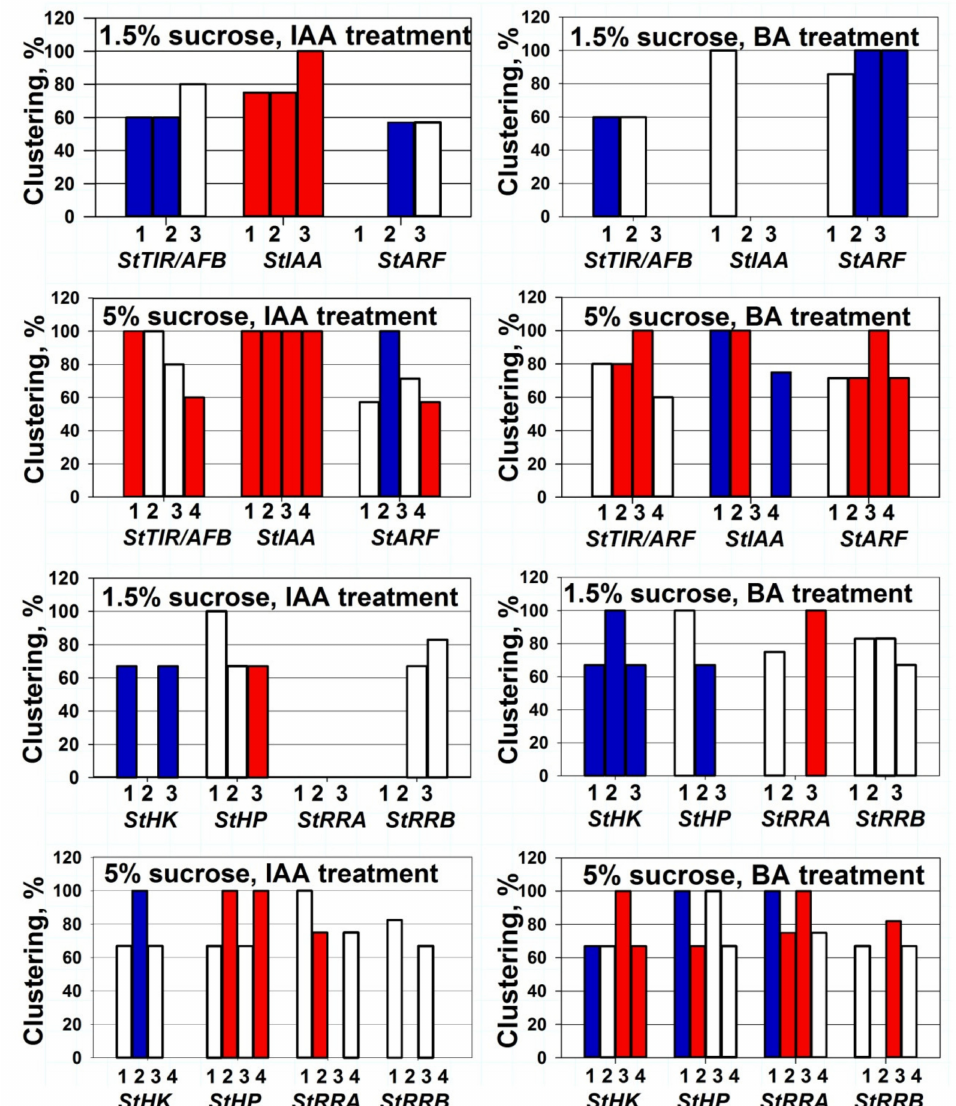
Figure 5. Cluster-like response (co-expression) of potato auxin/CK signaling genes to hormone treatments. 1, 2, 3, and 4 designate potato organs: leaves, stems, roots and tubers, respectively. Color indicates the change mode of cluster gene expression: up- or down-regulations are marked red or blue, respectively, and no significant changes (less than 1.5-fold) are not colored. Clustering % reflects percent of genes in the given family which respond uniformly to hormone treatment; clustering is considered relevant when it comprises more than 50% of genes of the given